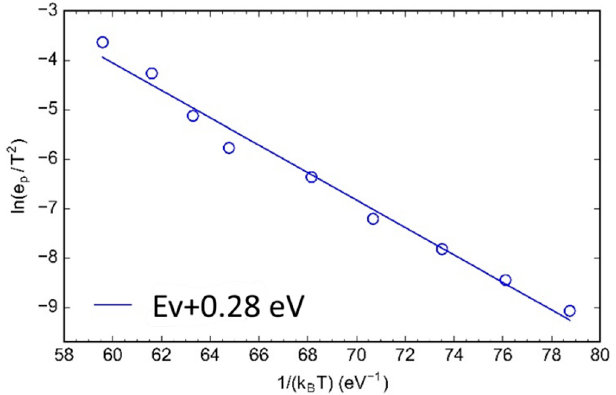
Figure 4. ArrheniusgraphfortheactivationenergyforholeemissionobtainedfromMCTSmeasurements Figure 4. Arrhenius graph for the activation energy for hole emission obtained from MCTS for the as-grown n -type 4H–SiC semi-transparent measurements for the as-grown n -type 4H–SiC semi-transparent SBD.